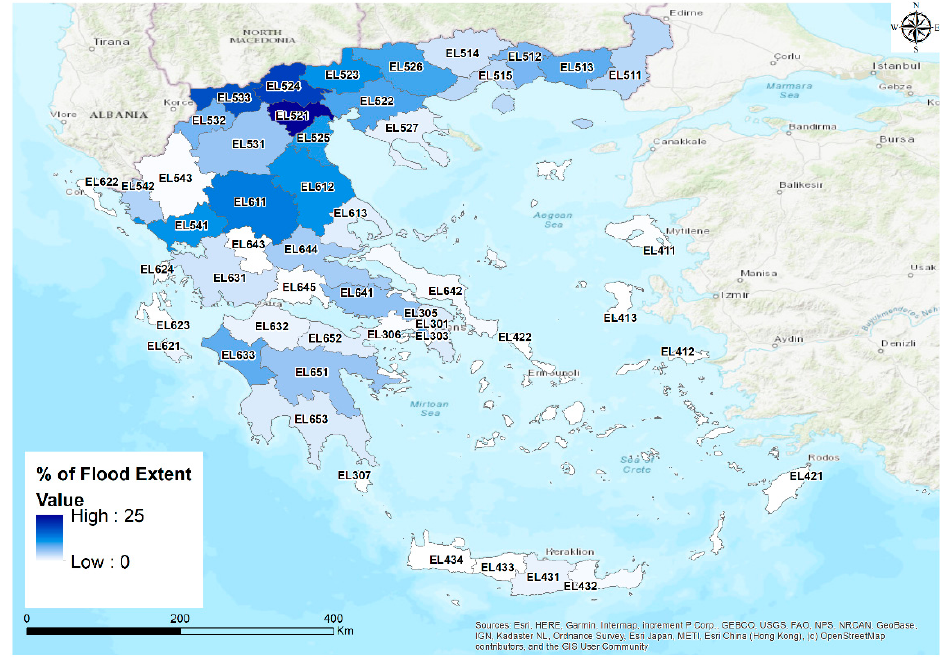
Figure 3. Spatial distribution of flood extent zones coverage per NUTS 3 in Greece.